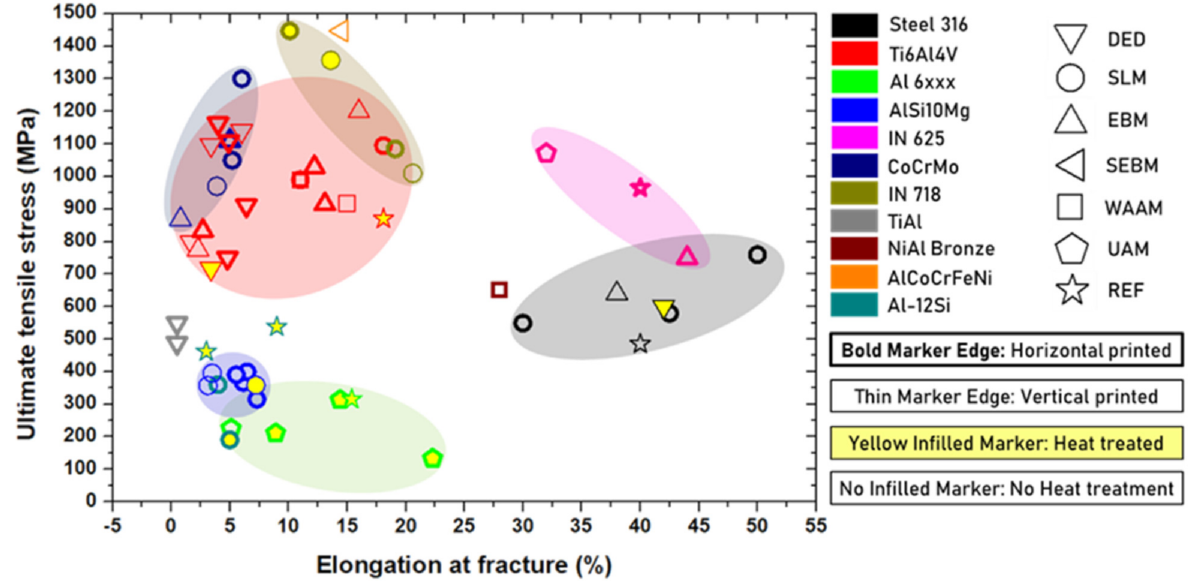
Figure 26. Selected values of fracture elongation verse ultimate tensile stress of various alloys from existing literature on metal AM